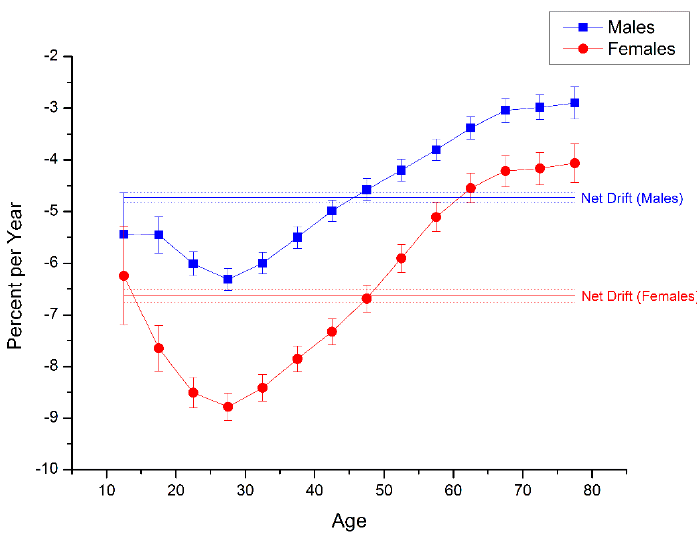
Figure 2. Local drift with net drift values for suicide rates by gender in China. Age group specific annual percent change (%) in the mortality rates of suicide and the corresponding 95% confidence intervals by gender in China.